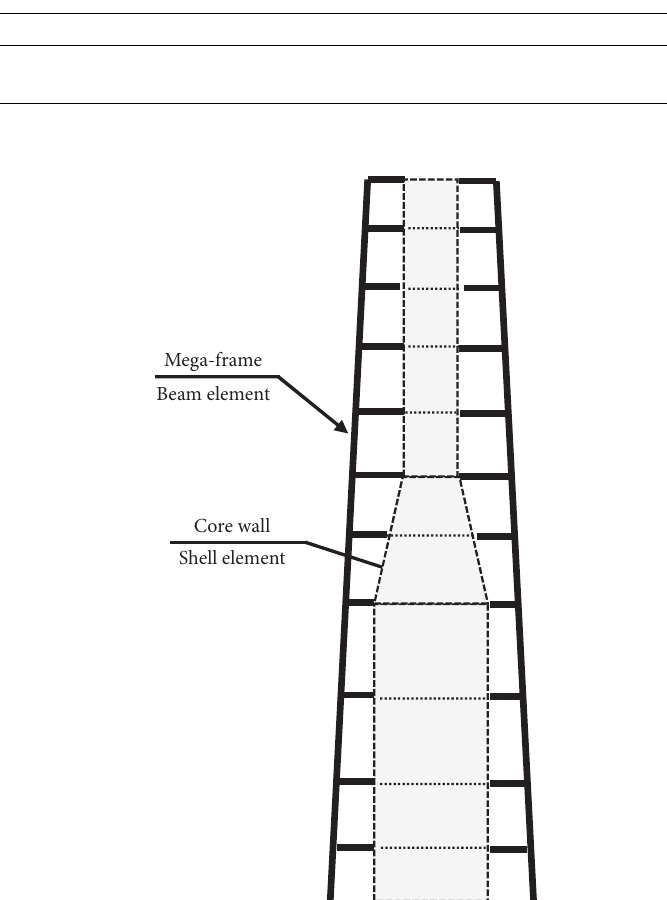
Table 1: The limit of vertex acceleration [25].